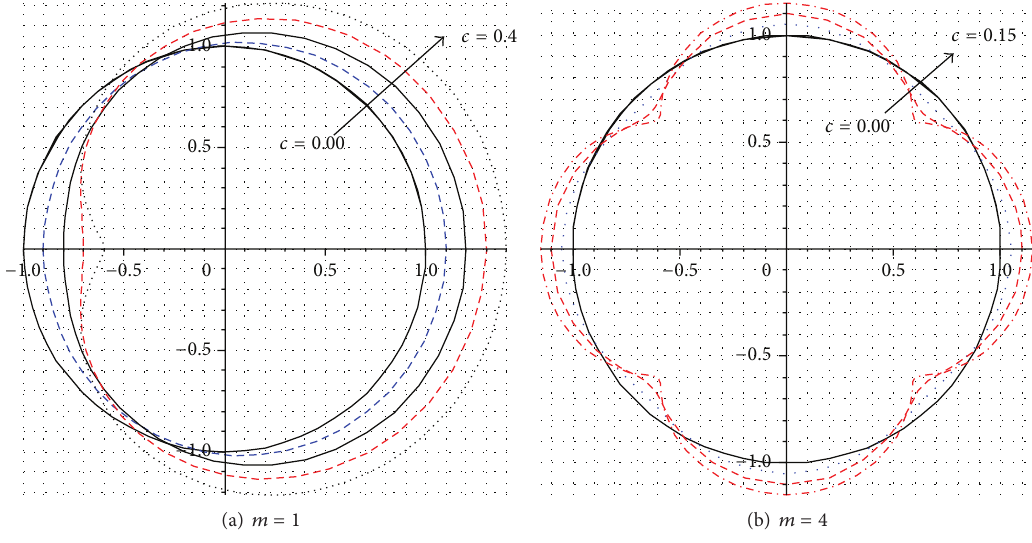
Figure 2: The domain of 𝑓(𝜁) with various 𝑚 and 𝑐 .